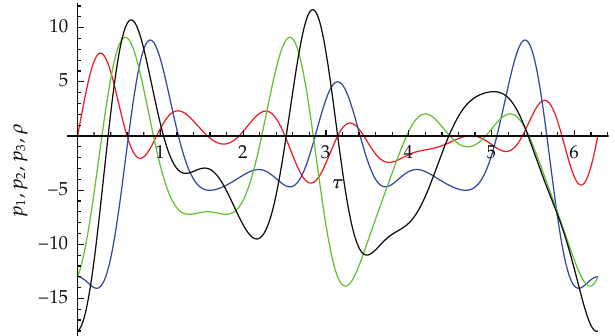
Figure 16: The plot of the EoS (cid:2) 4.9 (cid:3) , t ∈ (cid:4) 0 , 2 π (cid:5) , ρ (cid:2) red (cid:3) , p 1 (cid:2) blue (cid:3) , p 2 (cid:2) green (cid:3) , p 3 (cid:2) black (cid:3) .